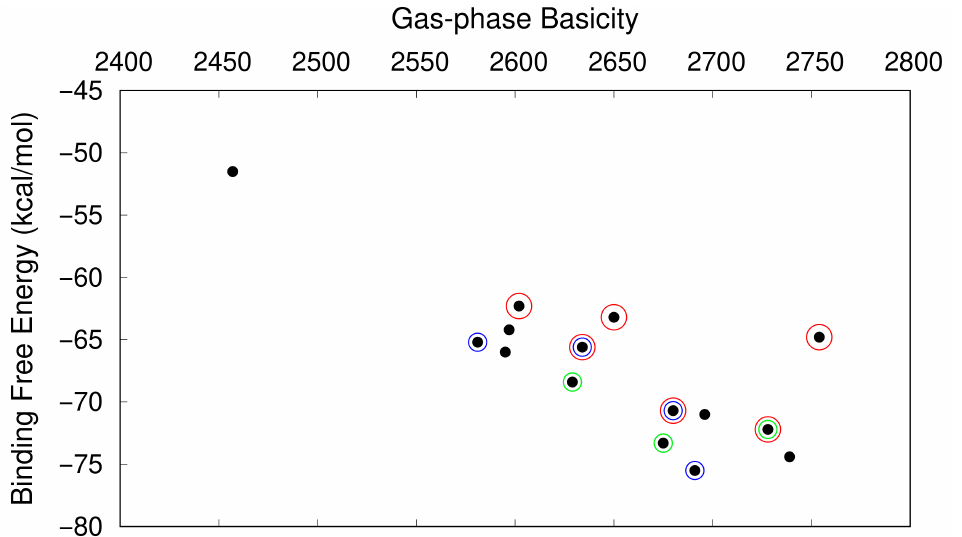
Figure 2. Correlation between the basicity of the clusters and the calculated binding free energies (at 298.15 K, 1 atm). The red circle indicates that TMA is present, the green circle includes DMA and includes both DMA and